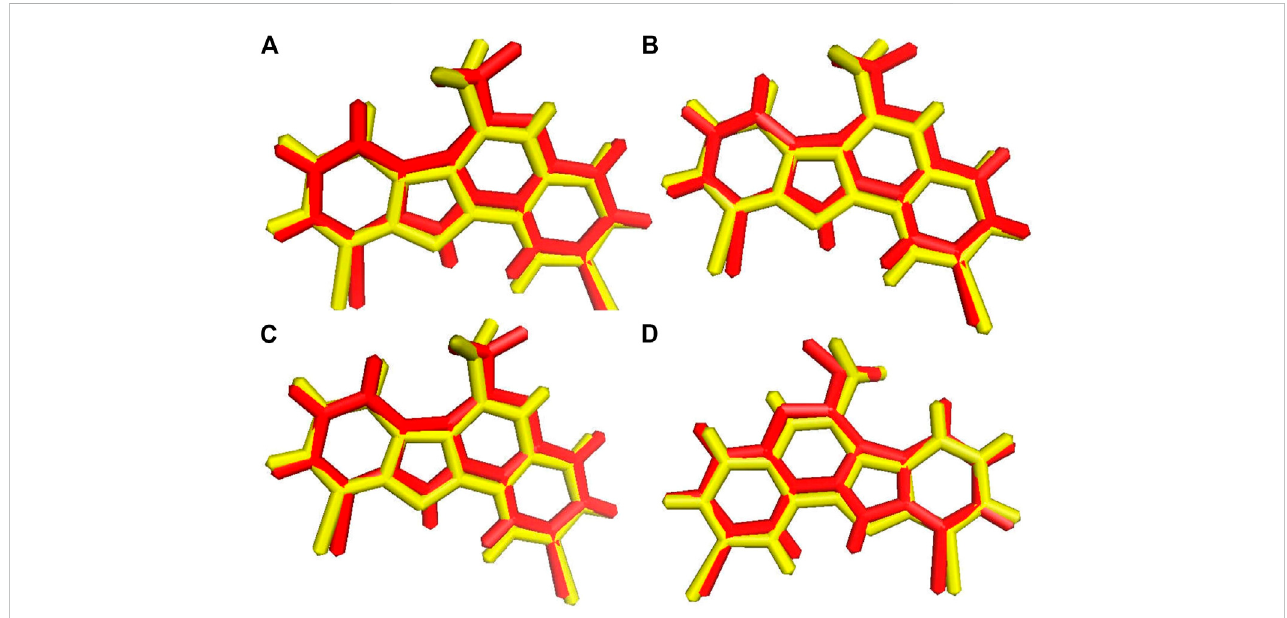
FIGURE 2 Ligand superimposition. (A) AutoDock. (B) AutoDock Vina. (C) Smina. (D) idock. The red and yellow colors represent the co-crystallized and docked ligands,